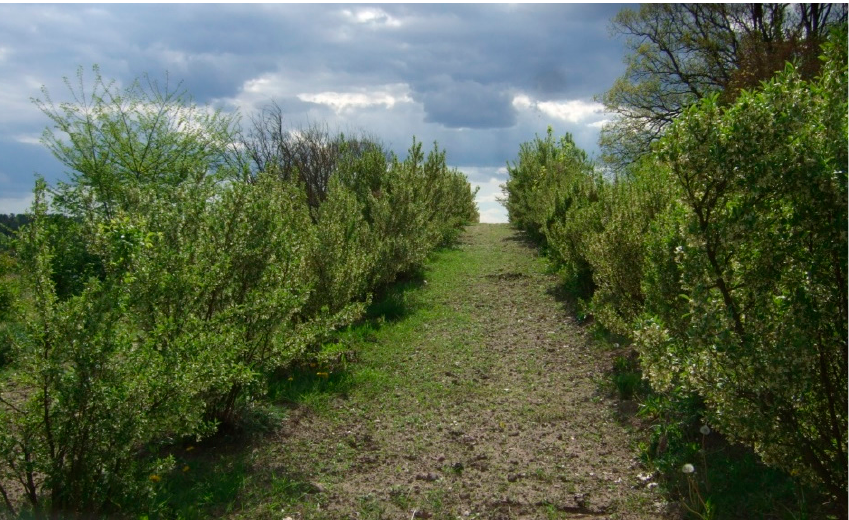
Figure 3. Elaeagnus multiflora growing in the Experimental Garden of the University of Warmia and Mazury in Olsztyn (north-eastern Poland). Mazury in Olsztyn (north-eastern